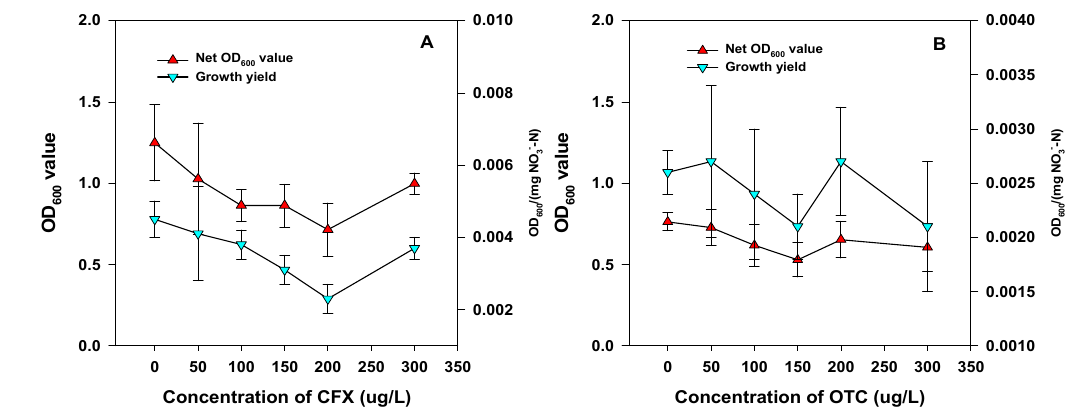
Figure 4. Growth behavior of strain RAD-17 in the presence of CFX ( A ) and OTC ( B ).